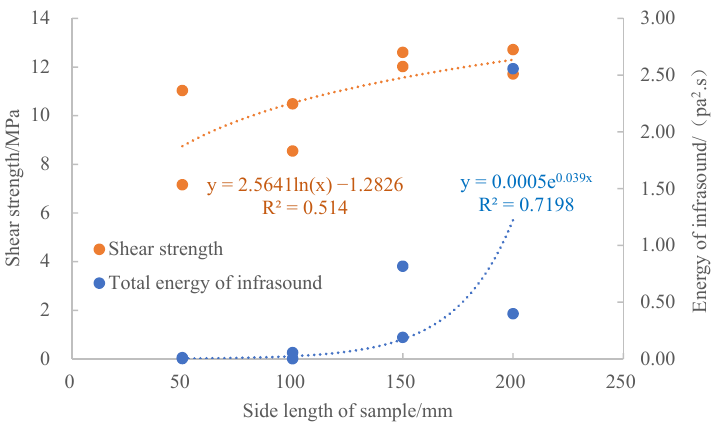
Figure 7. Relationship of shear resistance strength and infrasound energy amount.